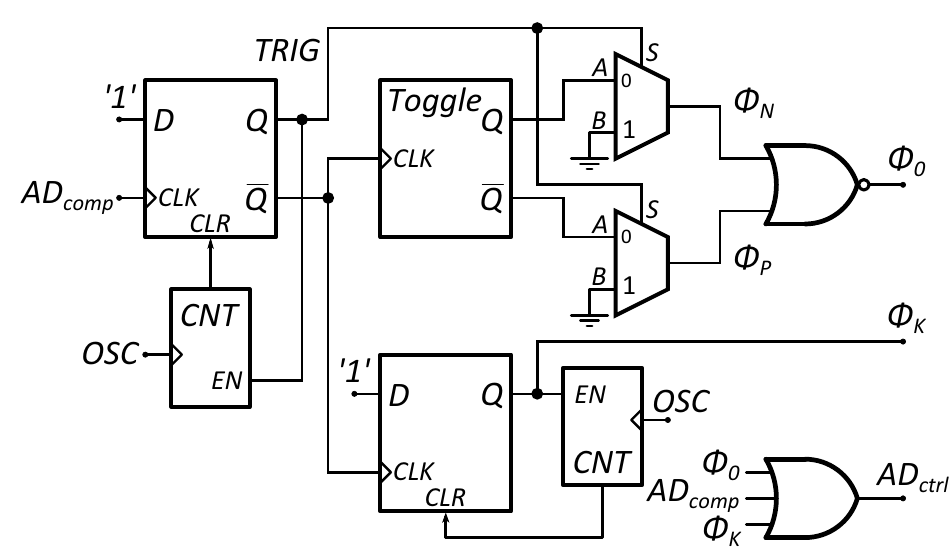
Figure 3. Architecture of the control